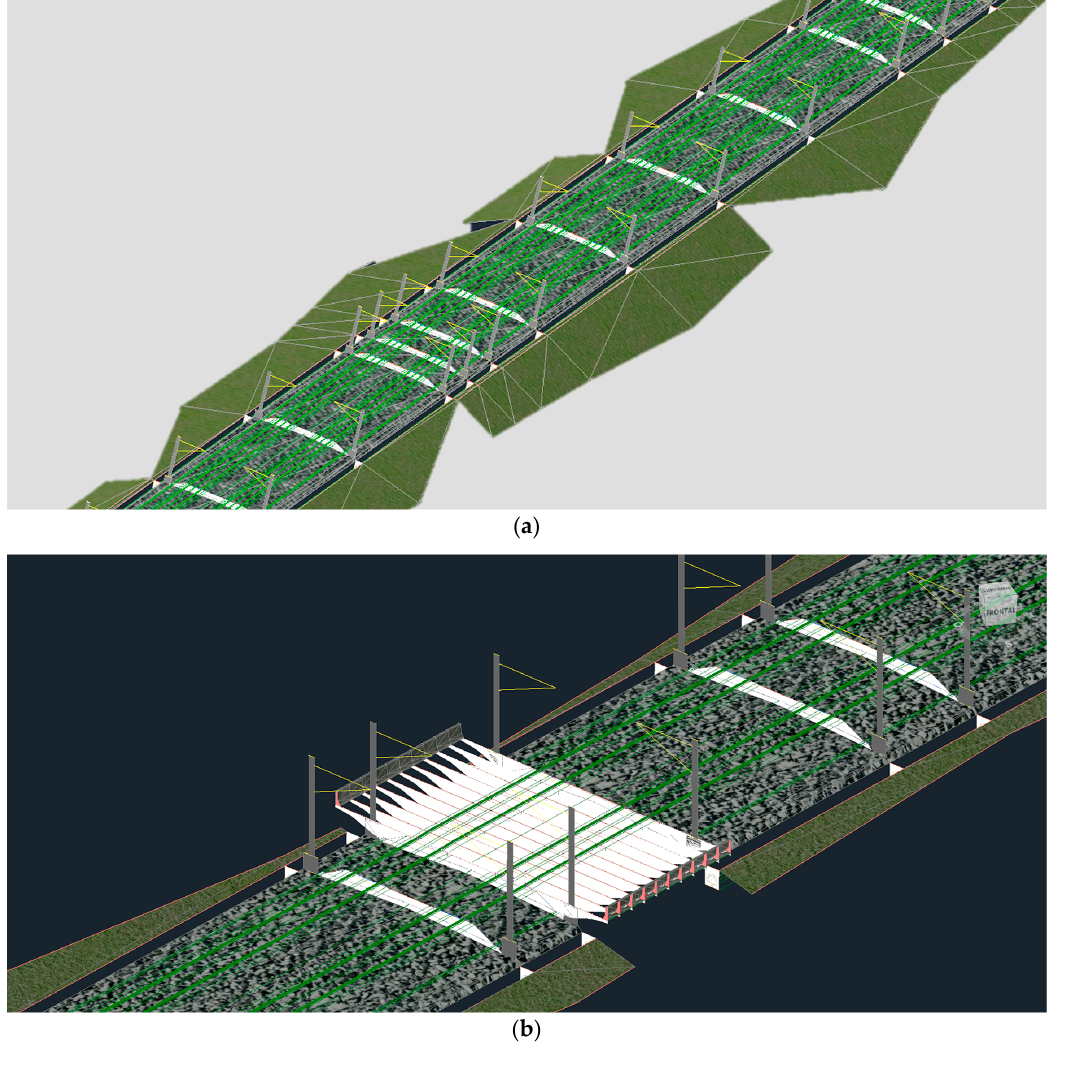
Figure 4. 3D modeling of the case study: ( a ) 3D model of the box culvert; and ( b ) general 3D